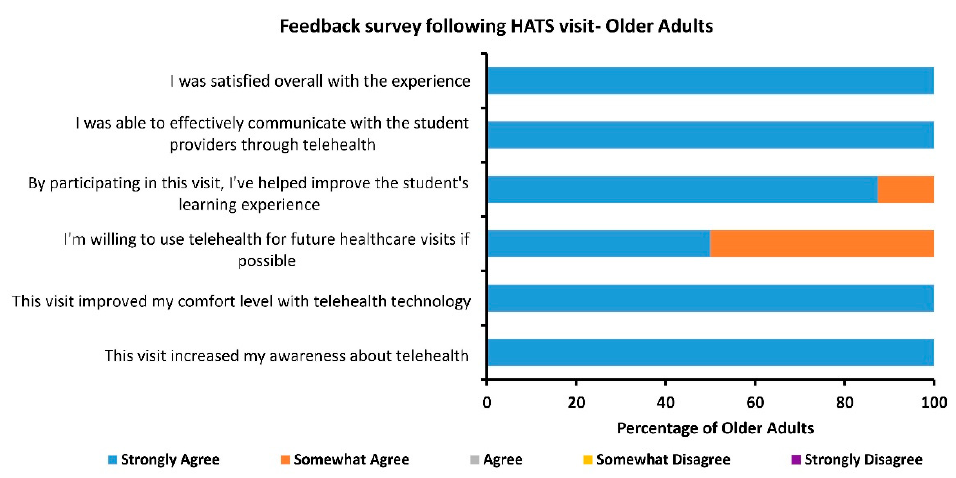
Figure 1. Results of the feedback survey given to participating older adults following the HATS telehealth visit.